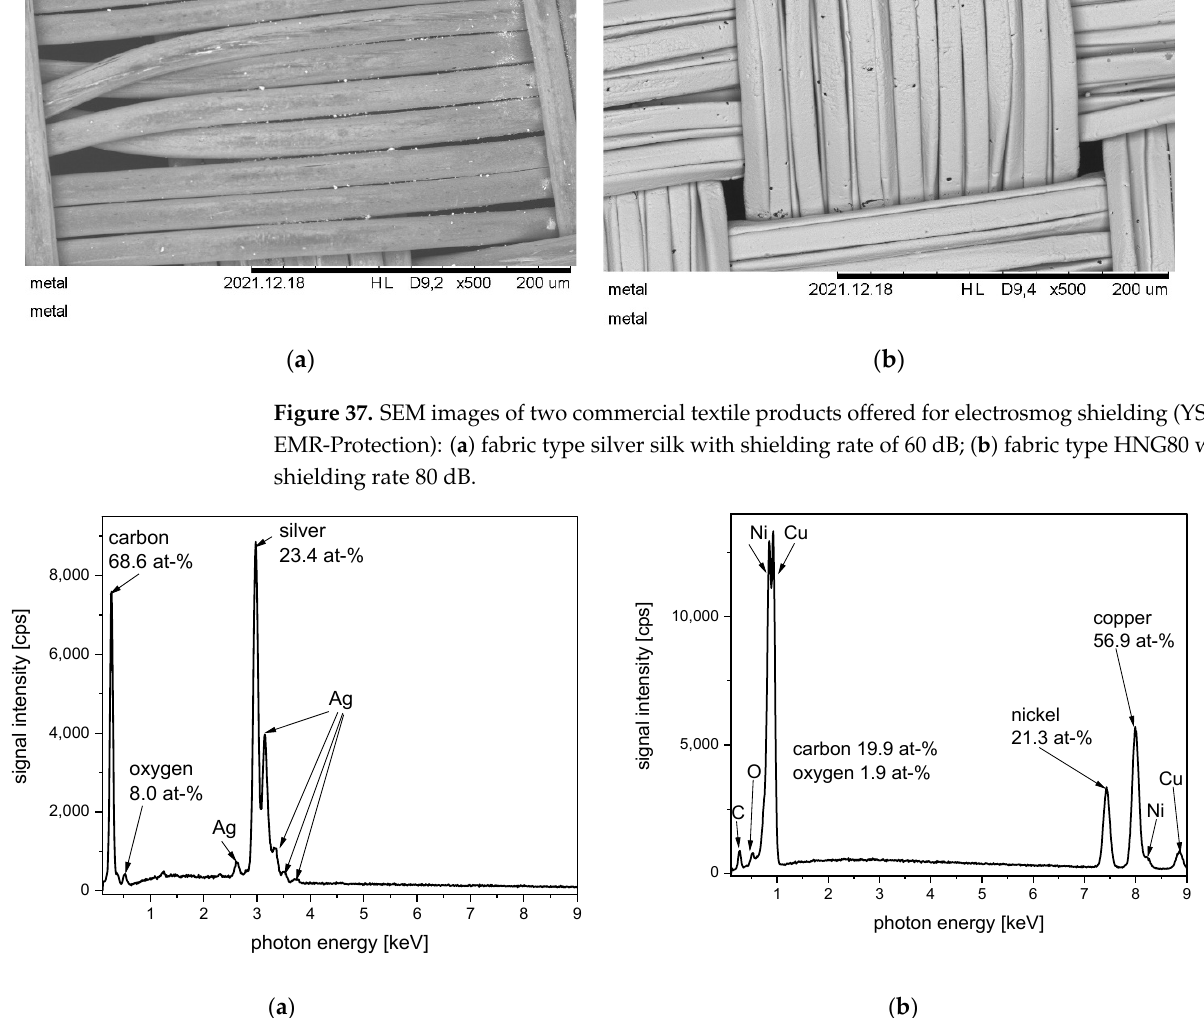
Figure 38. EDS spectra of two commercial textile products offered for electrosmog shielding (YShield EMR-Protection): ( a ) fabric type silver silk with shielding rate of 60 dB; ( b ) fabric type HNG80 with a shielding rate 80 dB.